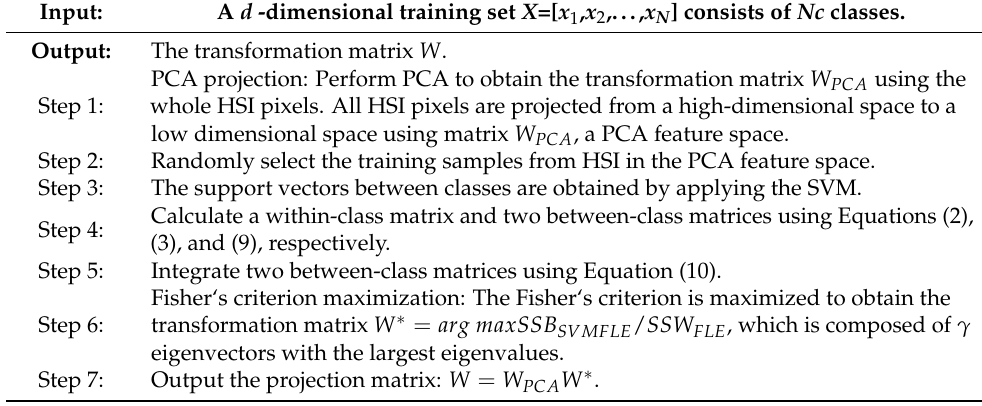
Table 2. The algorithm of SVMFLE